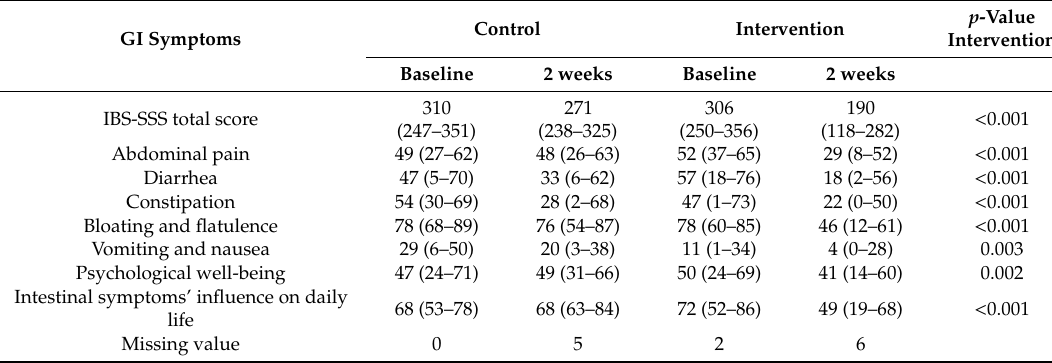
Table 6. The e ff ect on GI symptoms of the dietary